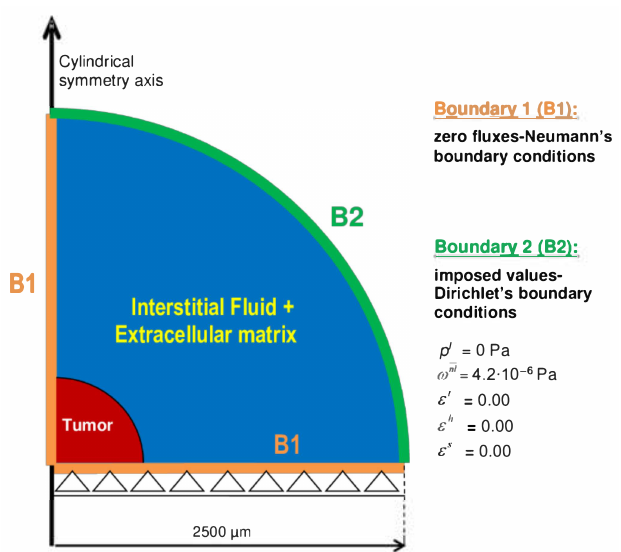
Figure 2. Geometry and boundary conditions of the problem. The computational domain is modeled as a spherical sector under axisymmetric conditions with a total radius of 2500 µ m. Initially, the tumor spheroid is composed of a TCs phase (red region, with a radius of about 200 µ m for tumor growing in Collagen type I (COL) and 250 µ m for tumor growing in Hyaluronic Acid (HA), the IF phase, and ECM which fill the whole domain. The atmospheric pressure is taken as the reference pressure and the initial IF pressure is zero in the entire domain. The initial volume fraction of TCs is